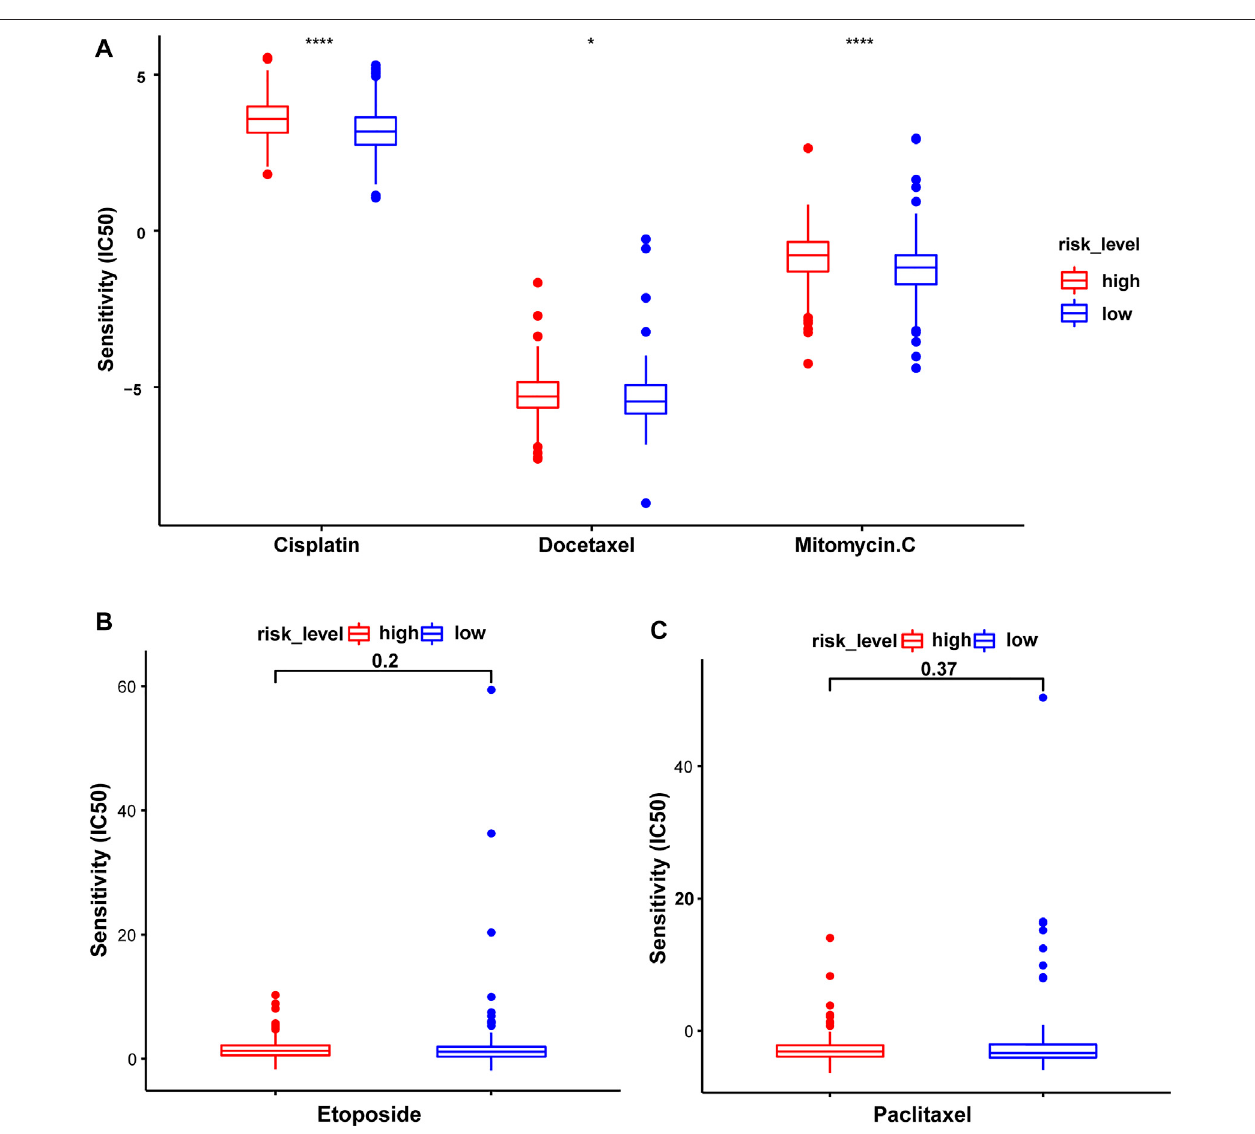
FIGURE 11 | The sensitivity to common chemotherapeutic drugs of patients with STAD in the test2 cohort. (A) Cisplatin, Docetaxel, and Mitomycin.C. (B) Etoposide. (C) Paclitaxel.